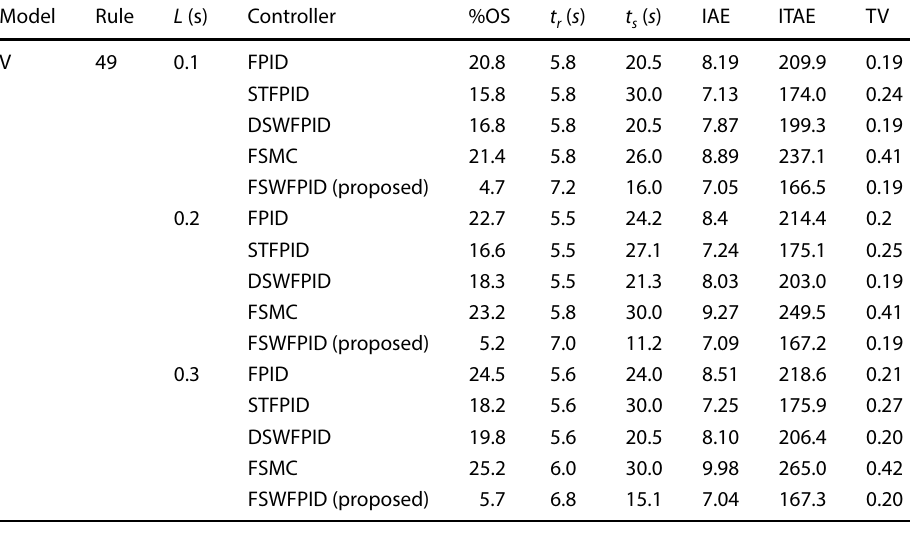
Table 16 Performance analysis for Model